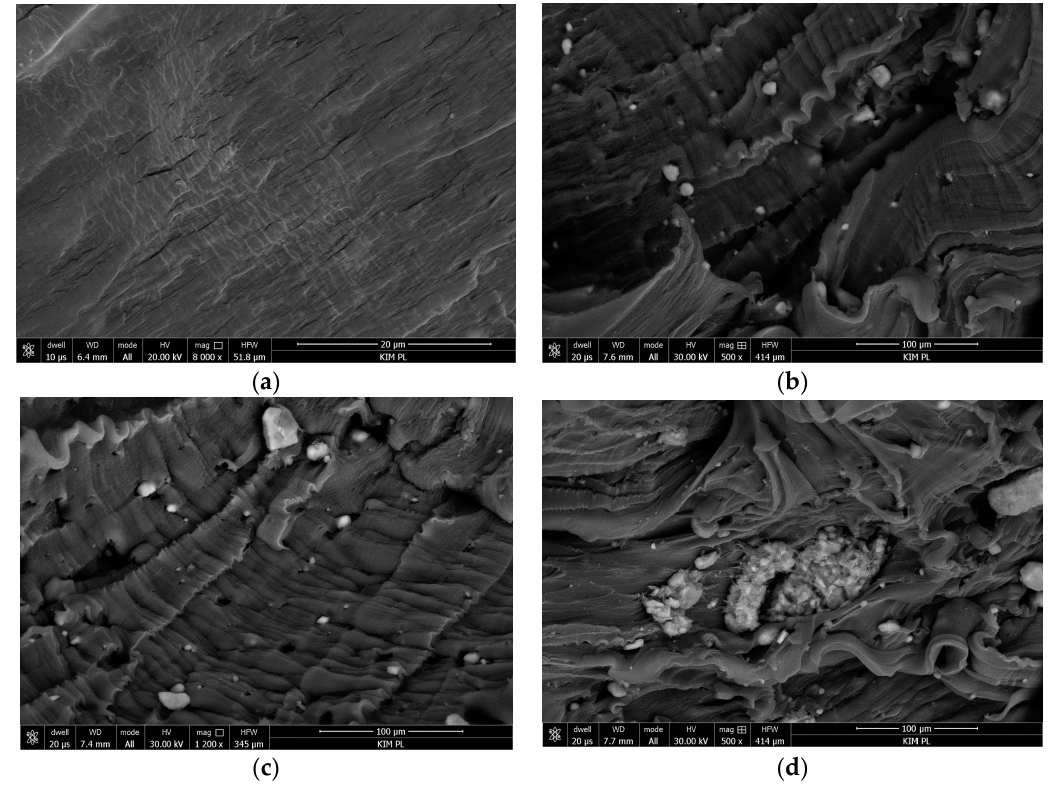
Figure 1. Images showing polyethylene without and with additives: ( a ) Sample No. 1, ( b ) sample No. 2, ( c ) sample No. 3 and ( d ) sample No. 4.